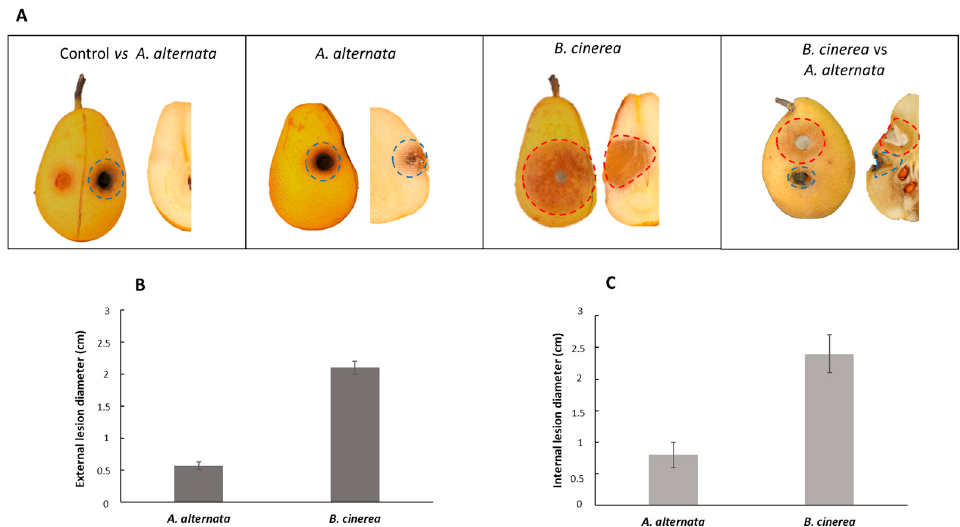
Figure 5. Pathogenicity assays on non-host Decana del Comizio pear fruits. ( A ) Pathogenicity test on pear fruits; ( B ) detection of external lesions on pear fruits; ( C ) detection of internal lesions on pear fruits.